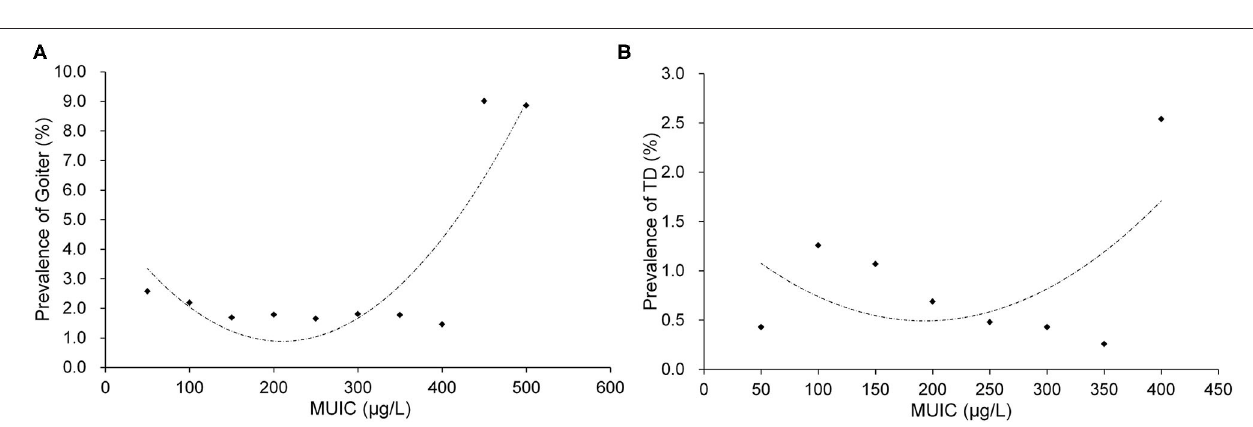
FIGURE 2 | The relationships of MUIC with goiter in children (A) and TD in pregnant women (B) . MUIC, median urine iodine concentration; TD, thyroid disease. (A) R 2 = 0.7763 and (B) R 2 = 0.3059.